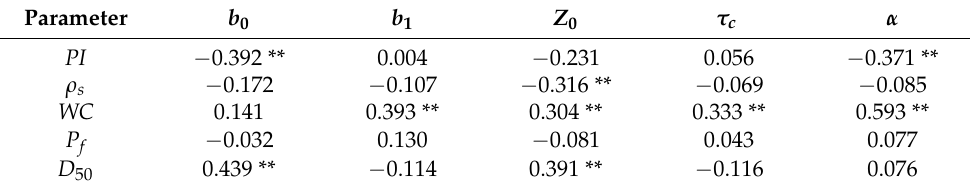
Table 2. Correlation analysis results of scouring parameters and soil parameters.